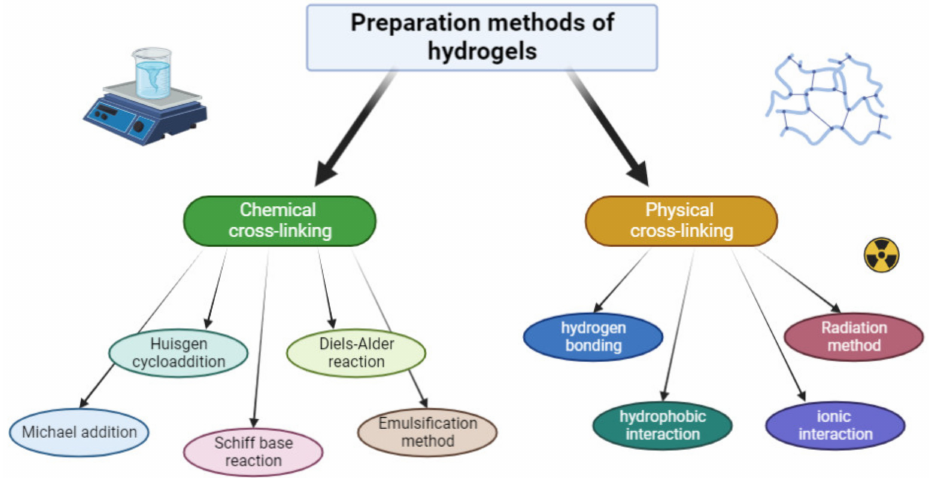
Figure 4. Schematic overview of the different cross-linking methods for preparing hydrogels based on